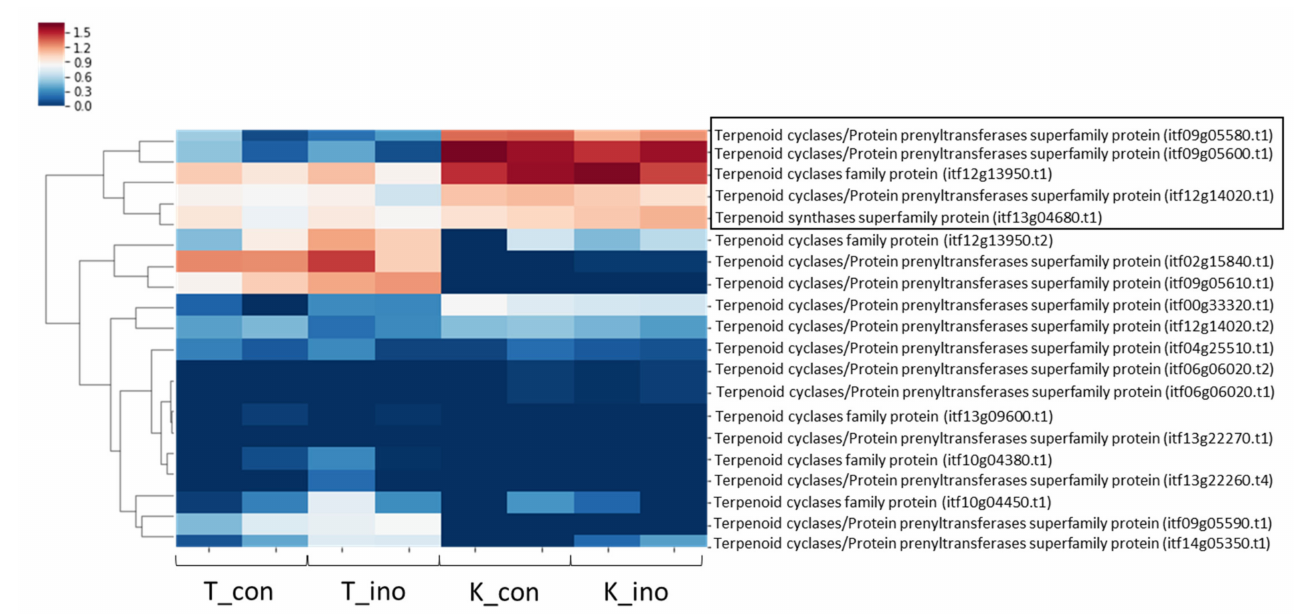
Figure 5. Hierarchical clustering and expression heatmap of 20 terpenoid-related genes. Black boxes indicate the genes that are highly differentially expressed between Kyushu No. 166 (K166) and Tamayutaka. The gene expression level (log2 fold change value) is represented by the blue (low) to red (high) color gradient. K_con: K166 samples in the control plot, K_ino: K166 samples in the inoculation plot, T_con: Tamayutaka samples in the control plot, T_ino: Tamayutaka samples in the inoculation